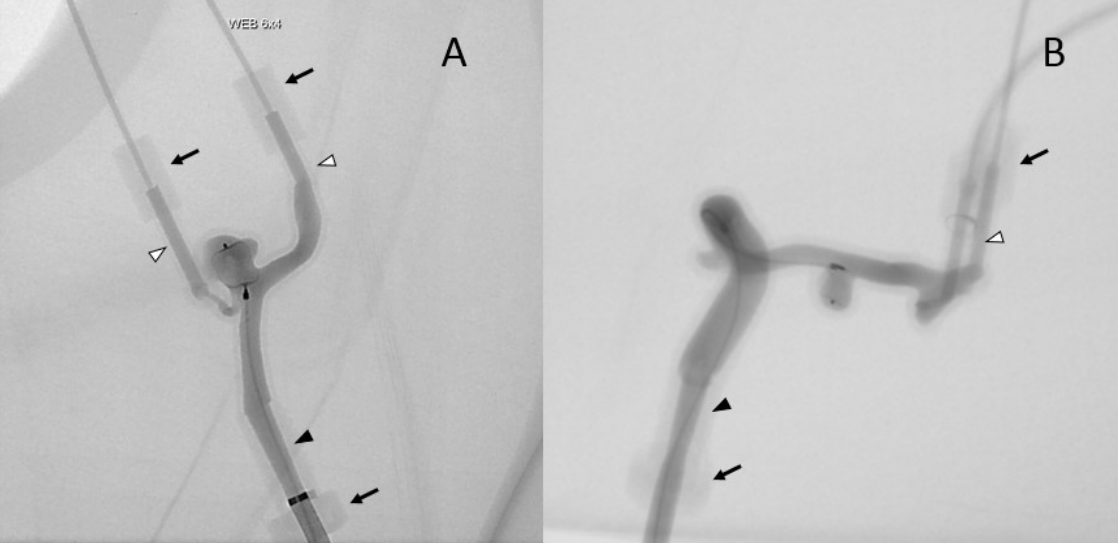
Figure 1. Injection of two 3D models ( A , B ) under fluoroscopy in the angio suite. Elongated point of entry of the vertebral artery ( A ) and internal carotid artery ( B ) (black arrowhead); elongated points of exit of the PICA and basilar trunk ( A ) middle cerebral artery ( B ) (white arrowheads) parallel to entry tube; soft waterproof plastic cylinders (black arrows).